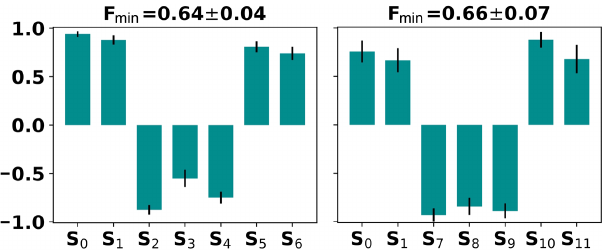
FIG. 7. Expectation values of the measured stabilizer operators for the two identity products related to the six-qubit H-shaped cluster